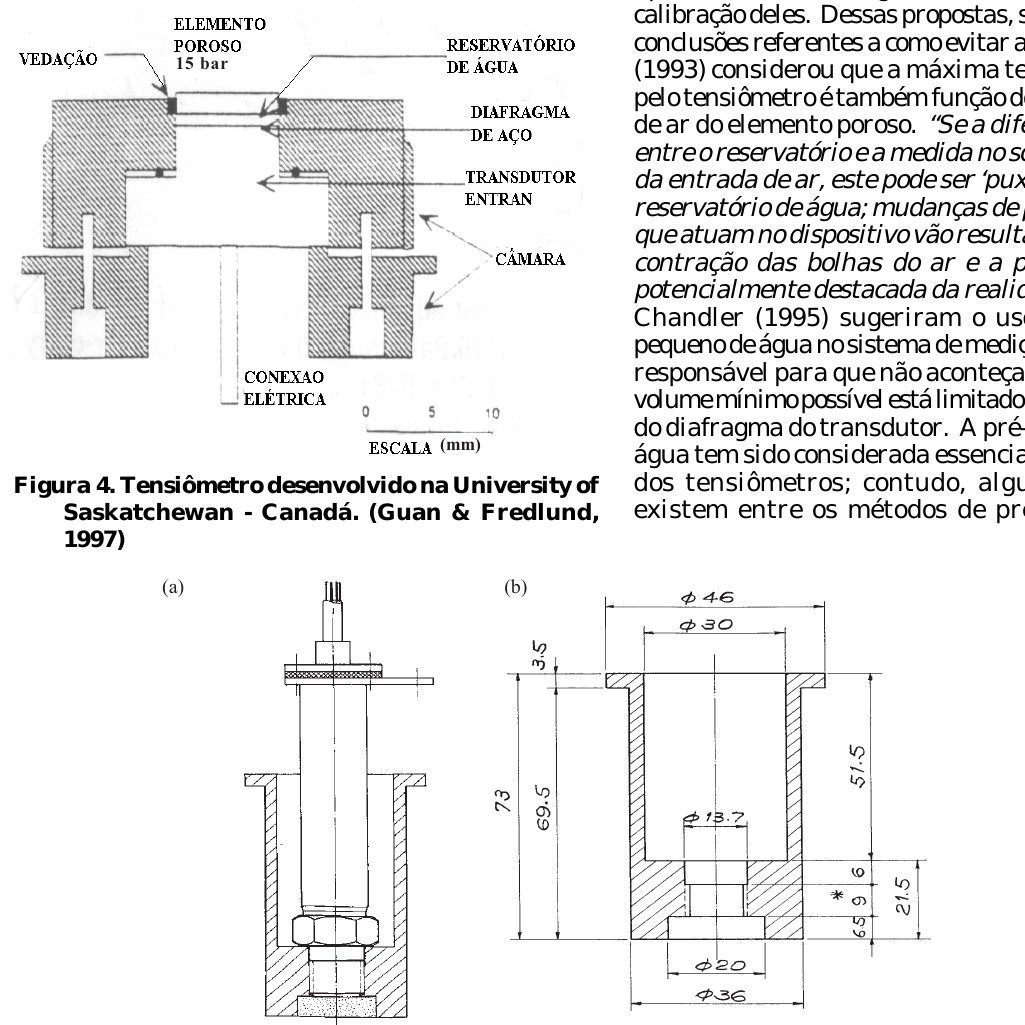
Figura 5. Tensiômetro desenvolvido na COPPE – UFRJ (a e b). (Pacheco, 2001; Mahler et al.,